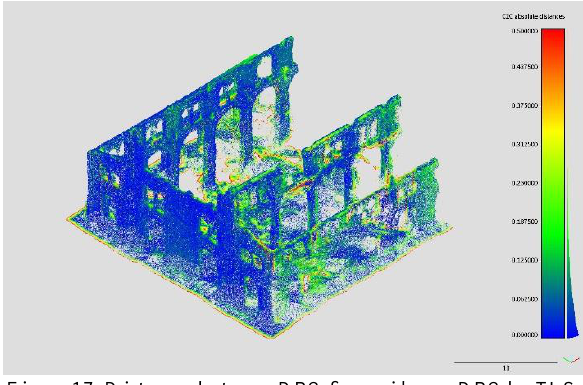
Figure 17. Distances between DPC from video vs DPC by TLS. Considering five SBM2017 results, a higher variability arises, anyway stating an increasing in the “UAV vs TLS” distances.